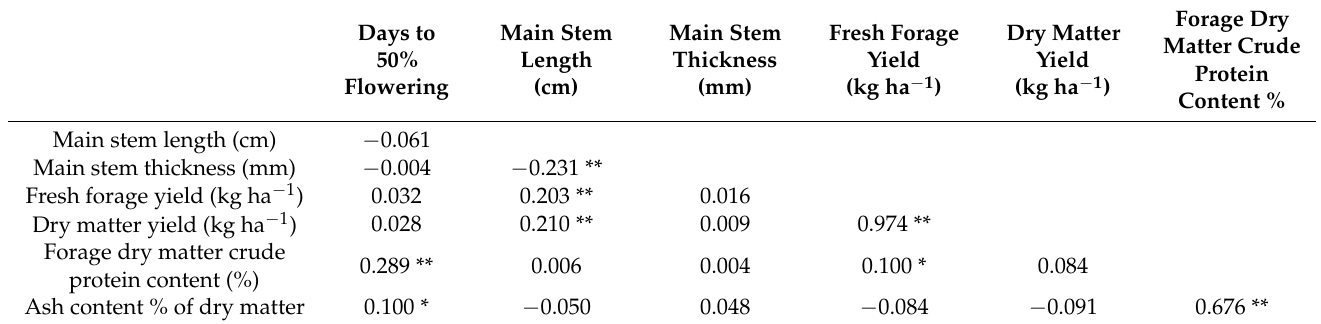
Table 6. Correlations between all traits measured: days to 50% flowering, main stem length (cm), main stem thickness (mm), fresh forage yield (kg ha − 1 ), dry matter yield (kg ha − 1 ), forage dry matter crude protein content (%), and ash content % of dry matter.